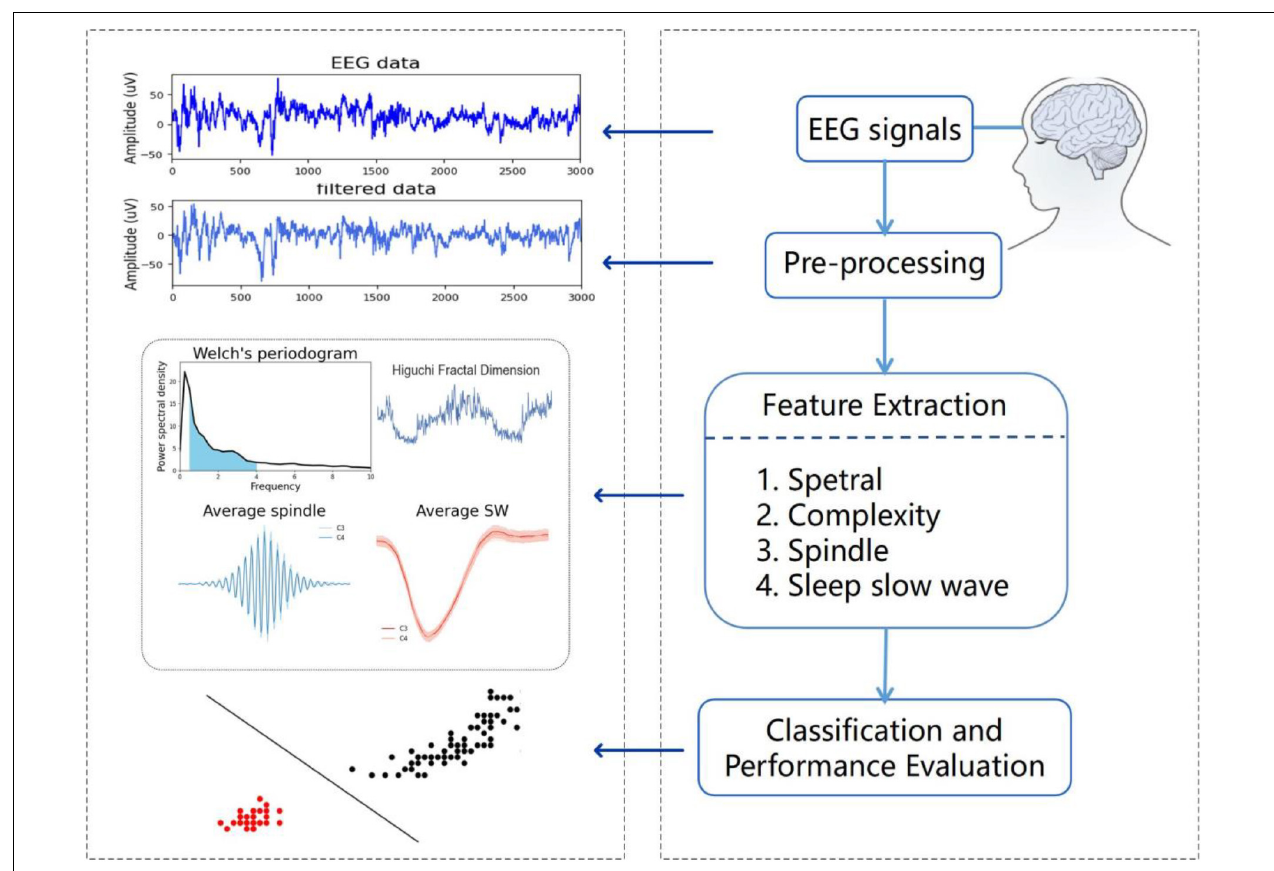
FIGURE 1 | Schematic diagram of proposed